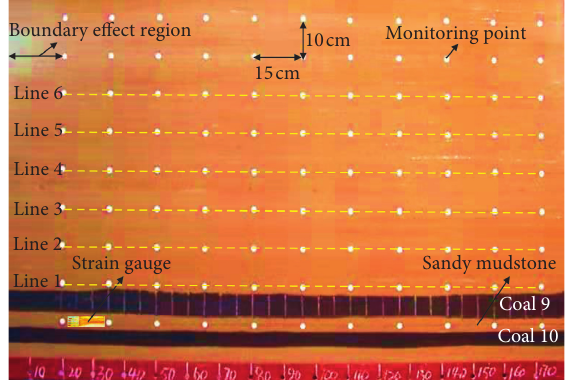
Figure 5: Similar simulation model and layout of monitoring points.